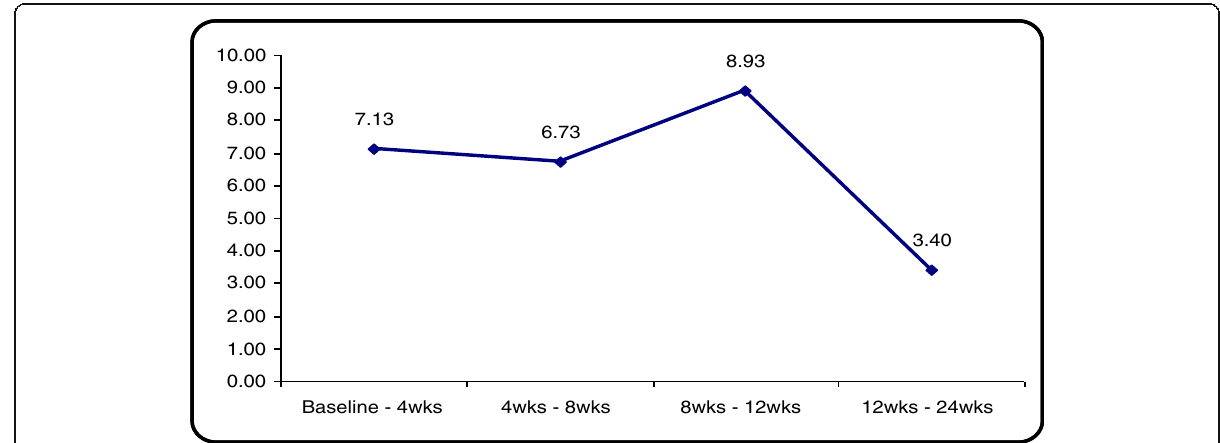
Fig. 5 A graph displaying the difference in the SPADI score between the four points of follow-up visits